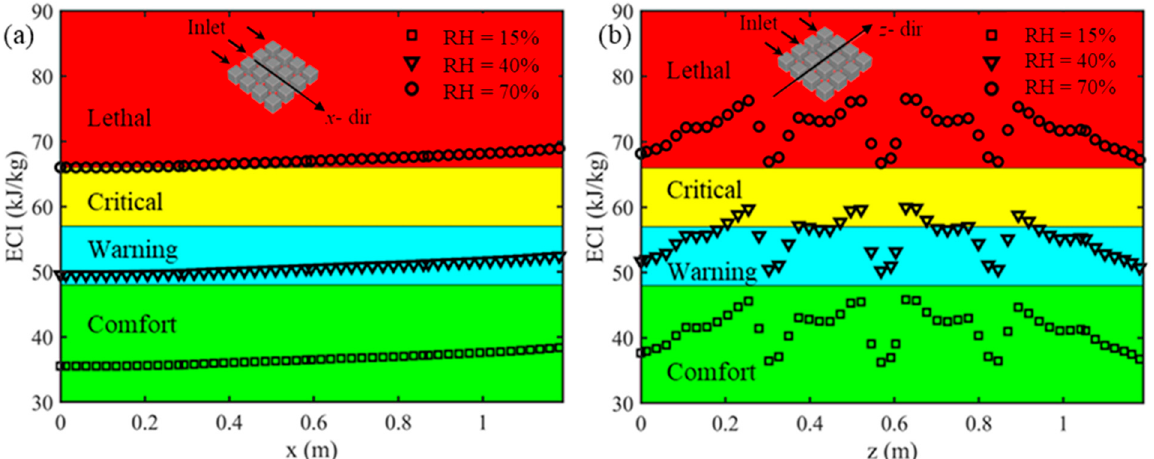
Figure 4. Effects of inlet air relative humidity on the enthalpy comfort index for inlet velocity of 0.5 m/s, inlet temperature of 300 k, and the broilers heat production of 150 W · m − 2 along ( a ) x -direction and ( b ) z -direction.